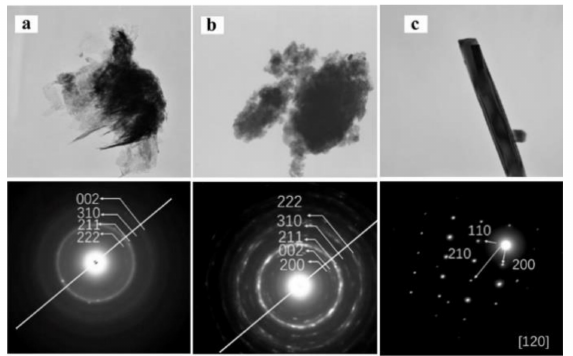
Figure 2. Transmission electron microscope (TEM) images and electron diffractions of HA5 ( a ), HA7 ( b ), and HA9 ( c )